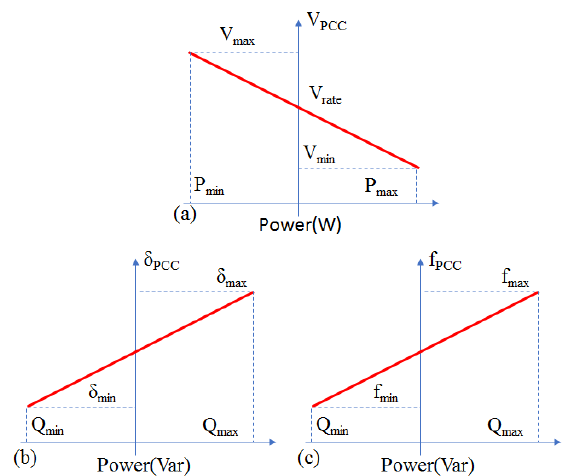
Figure 7. Relationship between power (P, Q) and measurements at the PCC. ( a ) Relationship between bus active power and voltage. ( b ) Relationship between bus reactive power and angle. ( c ) Relationship between bus reactive power and